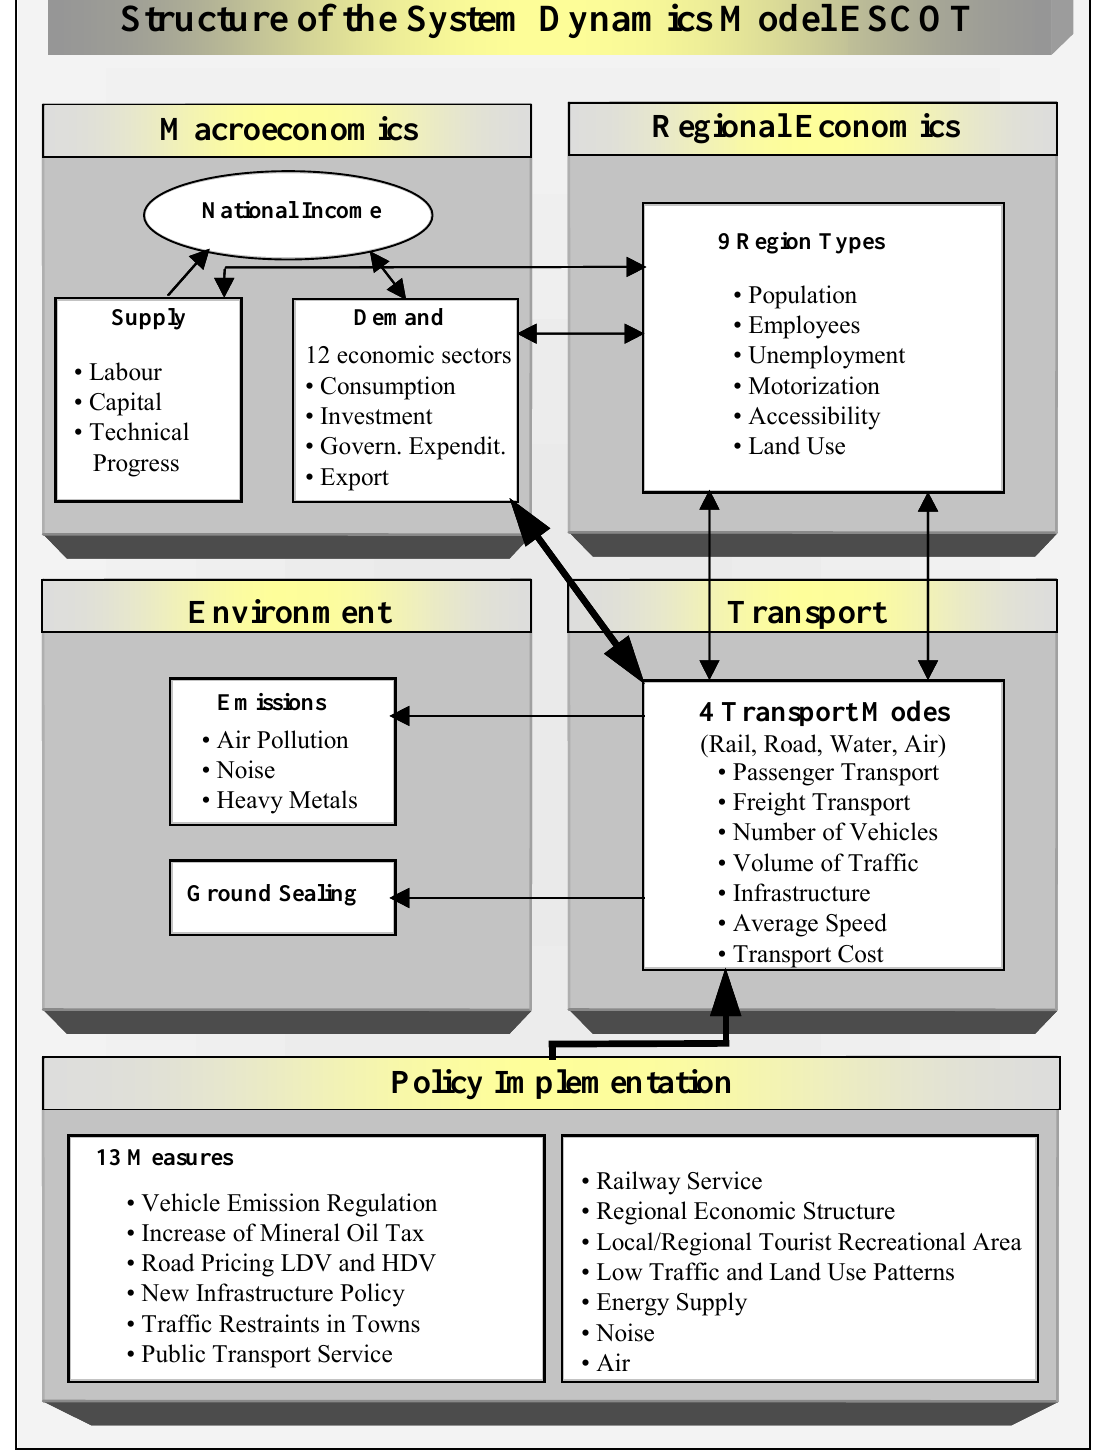
Figure 2. Structure of System Dynamics Model ESCOT with BAU/EST Policy